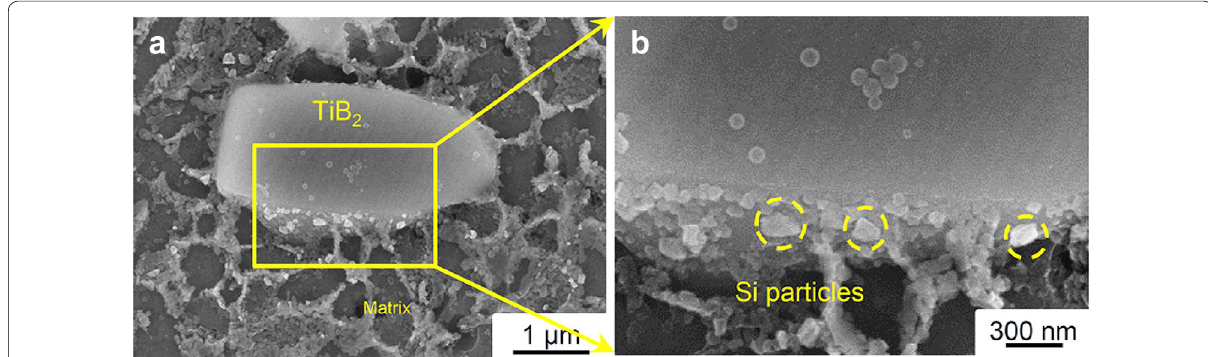
Figure 8 a FE-SEM images showing the morphology of the TiB 2 particle after SLM process; b high-magnification image showing the interface between TiB 2 particle and matrix, taking from the rectangle in